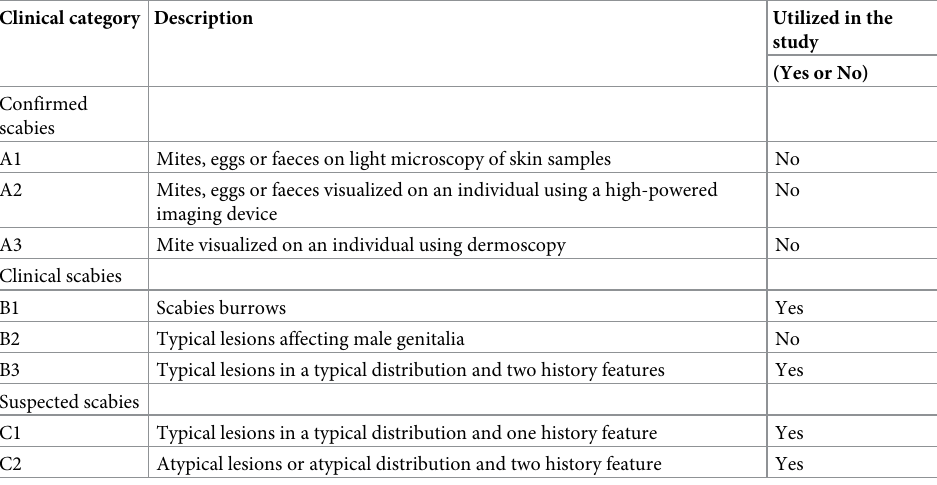
Table 1. International Alliance for the control of scabies consensus criteria for the diagnosis of Scabies, 2020. Clinical category